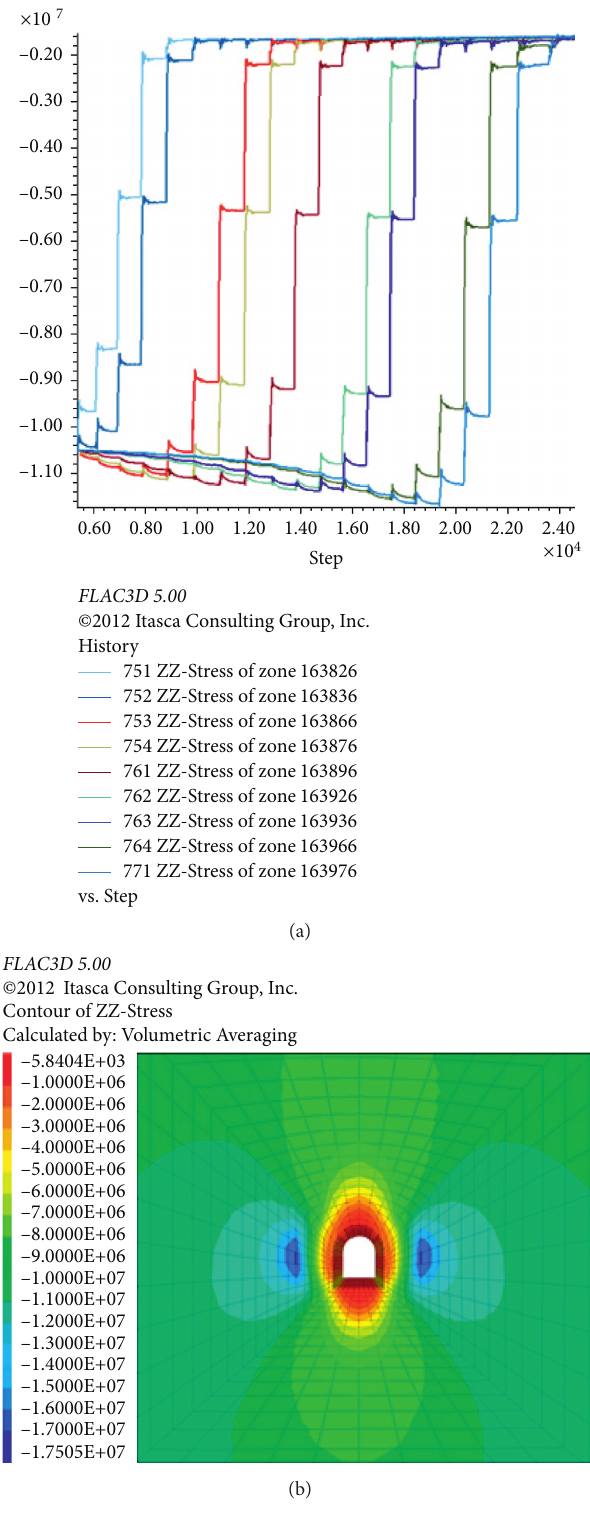
Figure 8: Variation of vertical stress of tunnel roof: (a) stress variation curve of tunnel roof and (b) stress variation cloud map of tunnel